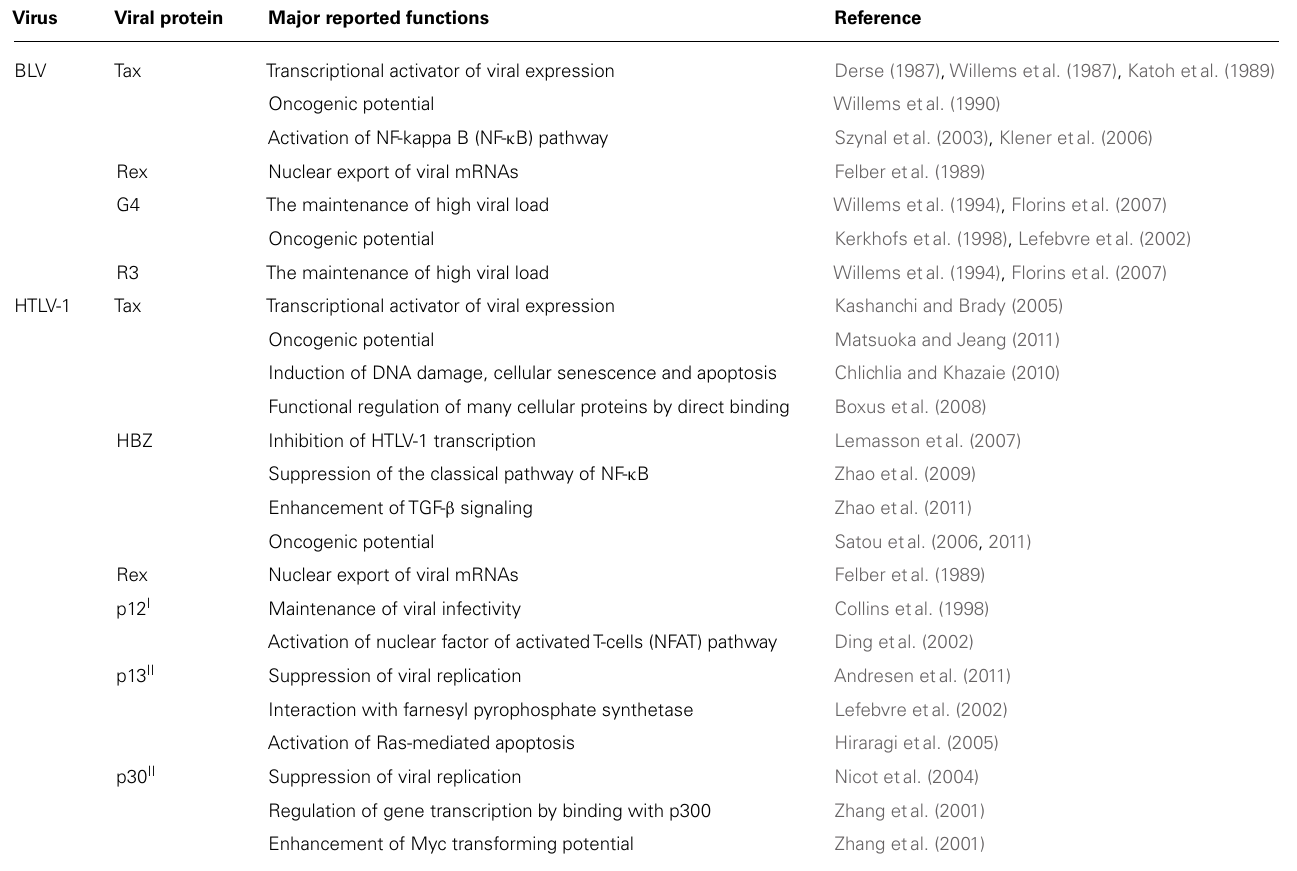
Table 1 |Viral proteins are encoded in BLV and HTLV-1 pX